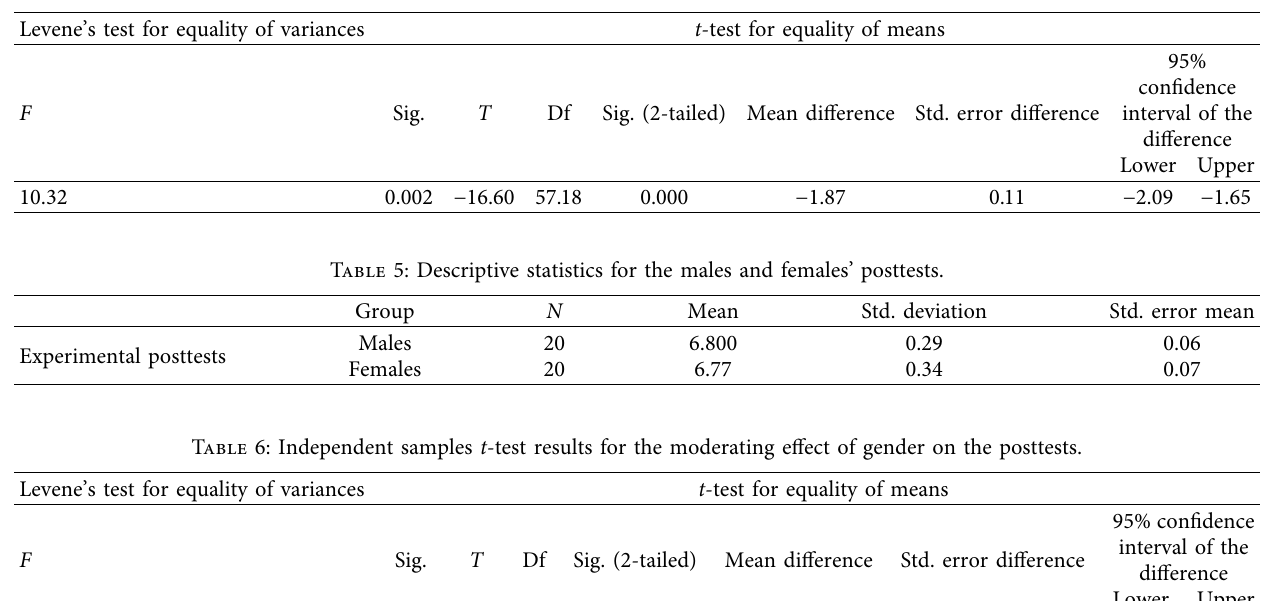
Table 4: Independent samples t -test results for the posttests.